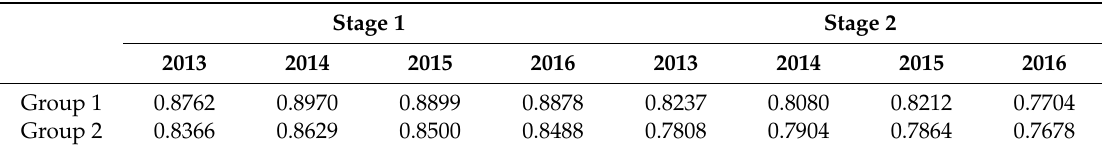
Table 4. Group e ffi ciency in